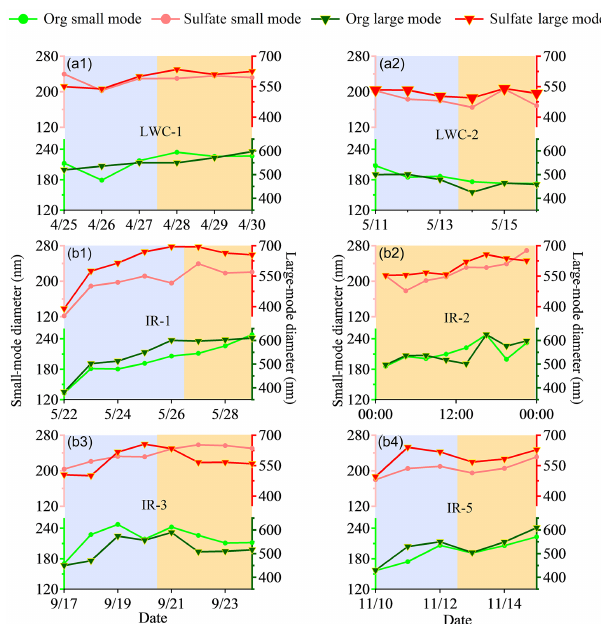
Figure 6. Variations in 24h averaged size distributions of fitted mass-mode diameters of organics and sulfates during LWC episodes and IR episodes (shaded in orange) and several days before each episode (shaded in blue). For the episode that lasted only for a day (E4), 3h averaged size distributions of fitted mass-mode diameters are shown instead. (a) LWC episodes and (b) IR